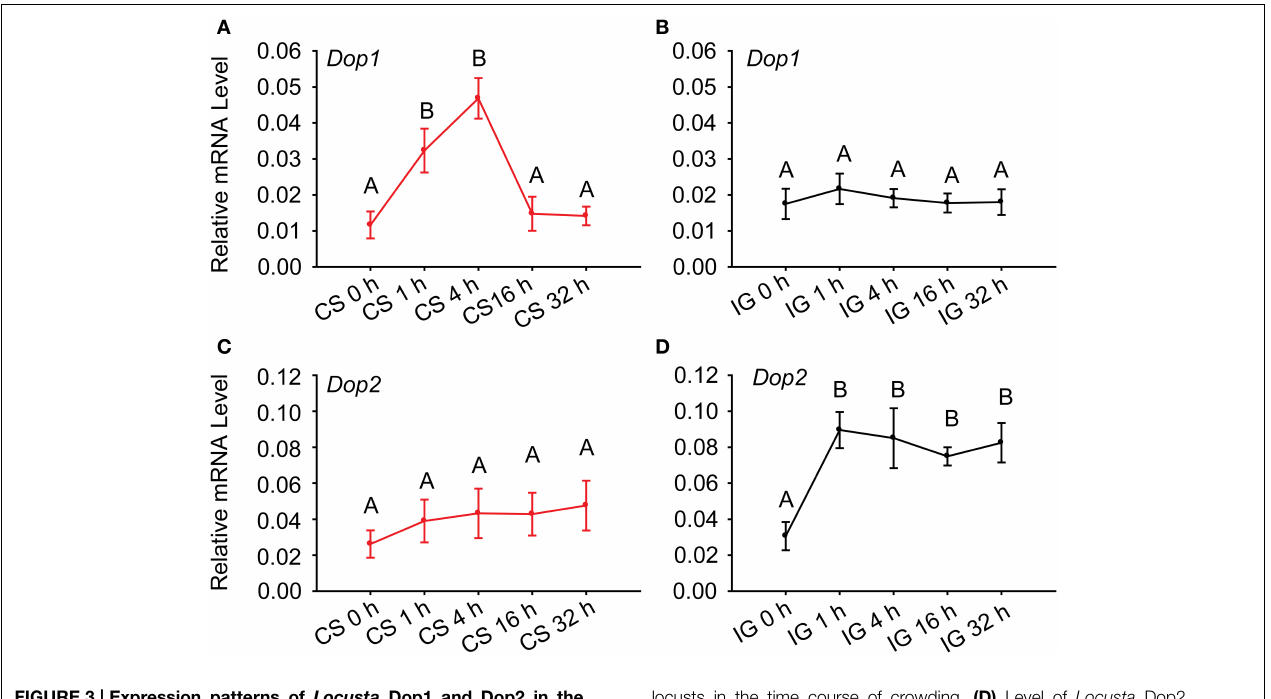
FIGURE 3 | Expression patterns of Locusta Dop1 and Dop2 in the brains of migratory locust during the time course of crowding and isolation. (A) Level of Locusta Dop1 mRNA in the brains of solitary locusts in the time course of crowding. (B) Level of Locusta Dop1 mRNA in the brains of gregarious locust in the time course of isolation. (C) Level of Locusta Dop2 mRNA in the brains of solitary